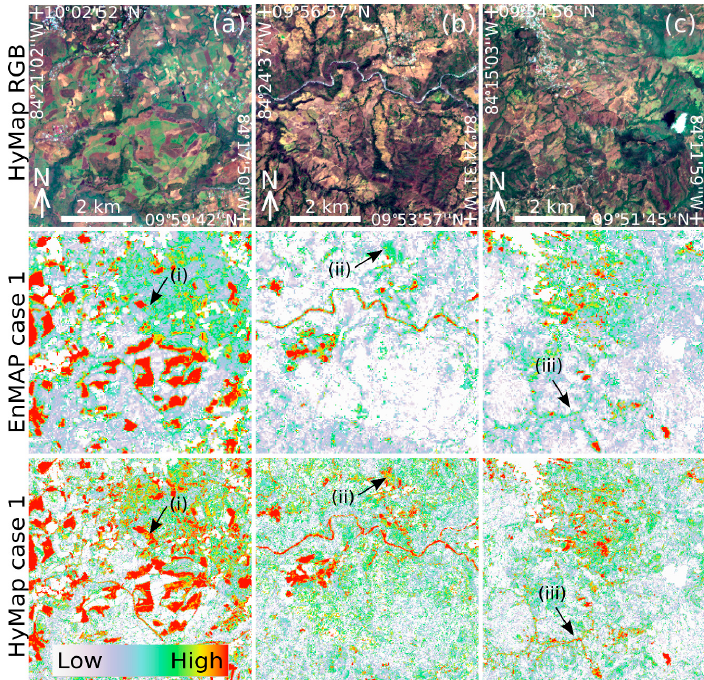
Figure 10. Zoom areas ( a ), ( b ) and ( c ) highlighting local differences between EnMAP and HyMap C-factor case 1 results. See text for details on zoom